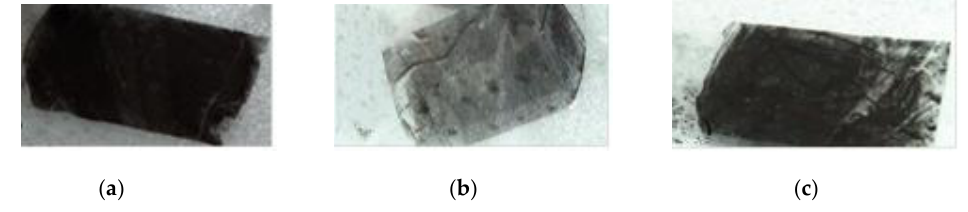
Figure 5. Cohesiveness of different electrodes: LFP-SK ( a ); LFP-CNT ( b ); LFP-G ( c ).